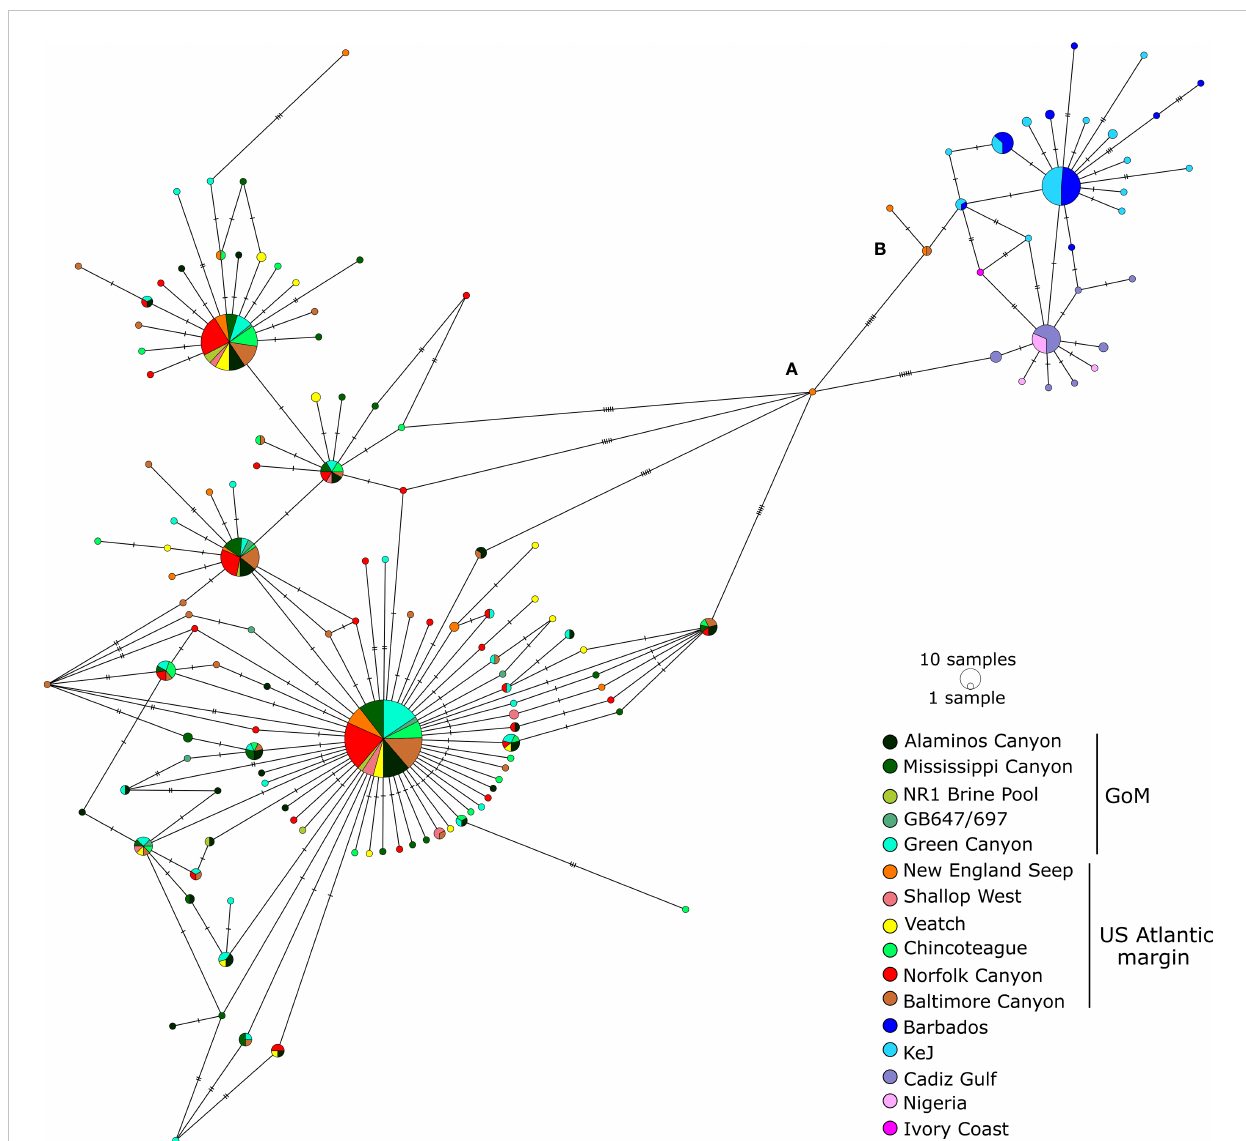
FIGURE 2 Haplotype network for the G. childressi/G. mauritanicus species complex. See Table 2 and Supplementary Table S1 for details about sequences included. Individuals (A, B) are highlighted as being the intermediate haplotype between both sides of the Atlantic Ocean (in New England seep) and the three G. mauritanicus sampled along the US Atlantic margin (Baltimore Canyon and New England seep), respectively. KeJ: Kick am Jenny, GoM: Gulf of